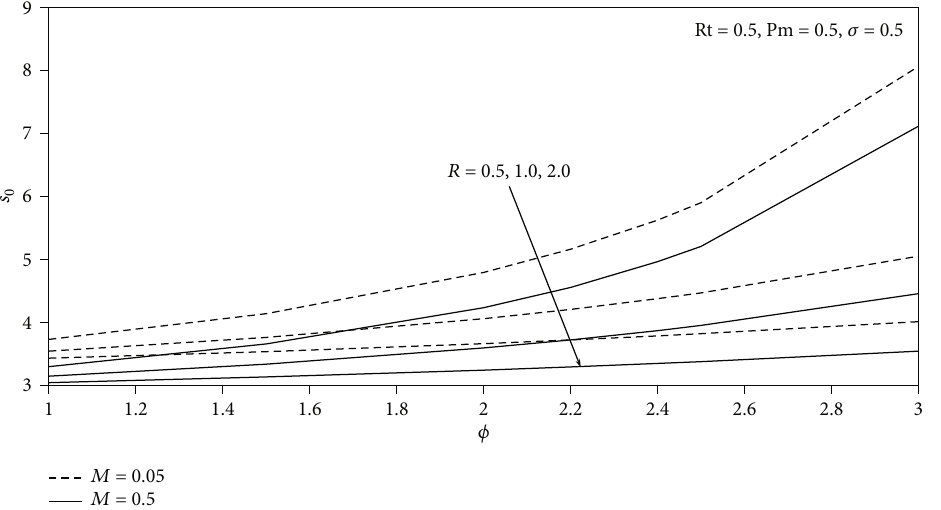
ϕ for di ff erent values of M and R . 0 Þ versus